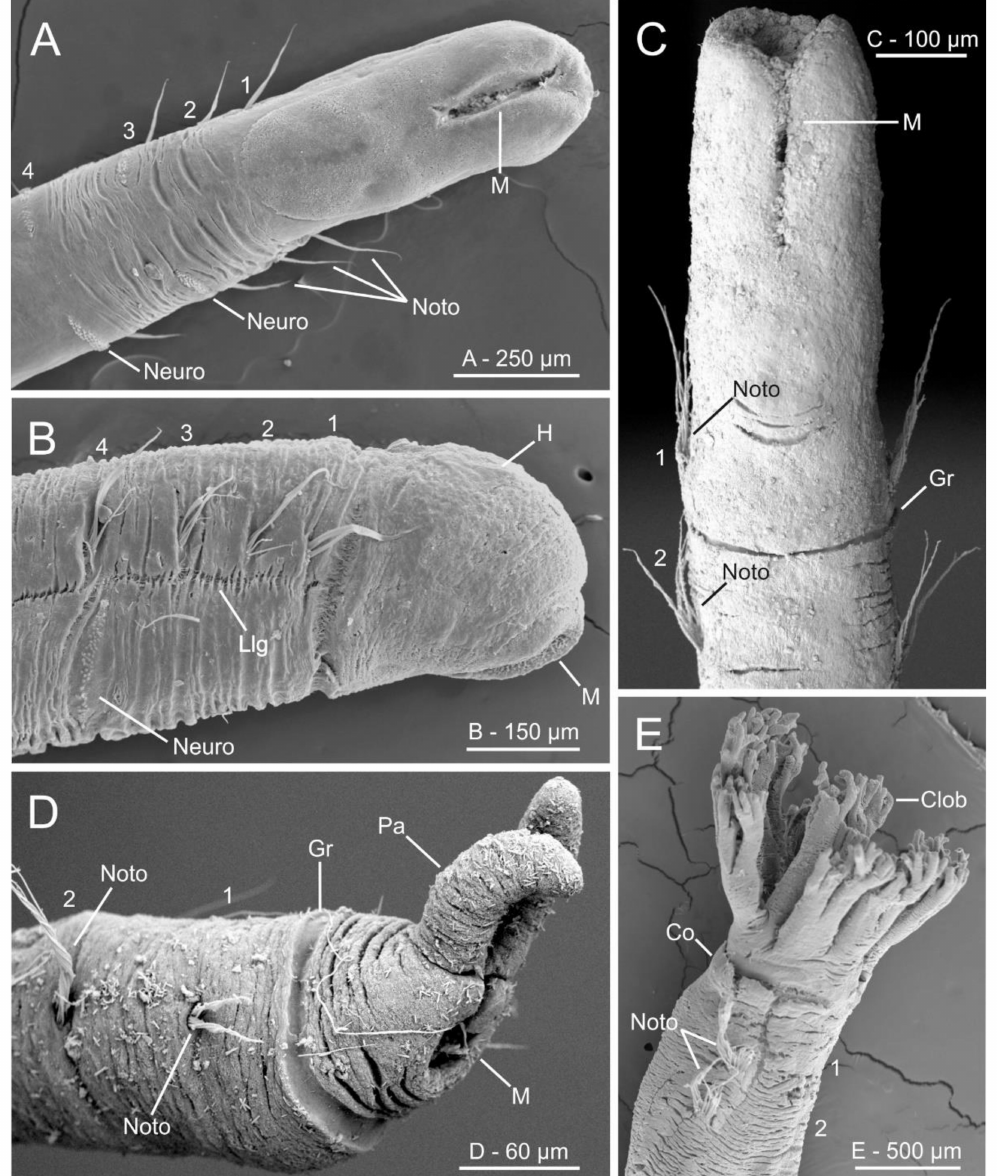
Figure 14. SEM micrographs of anterior end of representative species of all Oweniidae genera showing main diagnostic characters. ( A ) Myriochele olgae , ventral view; ( B ) M. heeri , lateral view; ( C ) Galathowenia quelis , ventral view; ( D ) Myri- owenia sp., lateral view; ( E ) Owenia fusiformis , lateral view. ( A , B ) Modified after Parapar [68], ( C , D ) after Capa et al. [17]. Chaetigers number provided. Abbreviations: Clob—crown lobe, Co—collar, Gr—groove, H—head, Llg—longitudinal lateral groove, M—mouth, Neuro—neuropodium, Noto—notopodium,